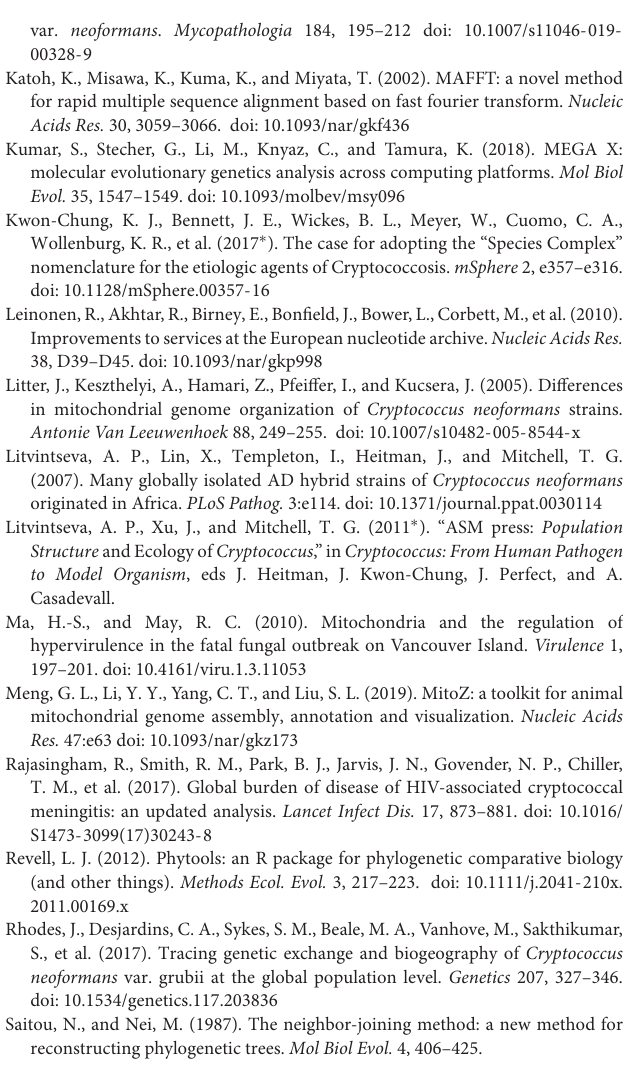
FIGURE S5 | Co-phylogenetic tree of COB concatenated exons and COBi1. FIGURE S6 | Co-phylogenetic tree of COB concatenated exons and COBi2. FIGURE S7 | Co-phylogenetic tree of COX1 concatenated exon and COX1i1. FIGURE S8 | Co-phylogenetic tree of COX1 concatenated exon and COX1i2. FIGURE S9 | Co-phylogenetic tree of COX1 concatenated exon and COX1i3. FIGURE S10 | Co-phylogenetic tree of COX1 concatenated exon and COX1i4. FIGURE S11 | Co-phylogenetic tree of COX2 concatenated exon and COX2i. FIGURE S12 | Co-phylogenetic tree of ND1 concatenated exon and ND1i. TABLE S1 | Mitogenome size and intron number distributions among nuclear genome-based clades, geographic regions, ecological niches, and mating types. TABLE S2 | Details of all strains analyzed in this study. Included in this table for each strain are strain name, geographic origin, ecological niche, mating type, GenBank accession numbers, mitogenome size, intron number and distributions, summed intron length, summed exon length, and summed intergenic spacer